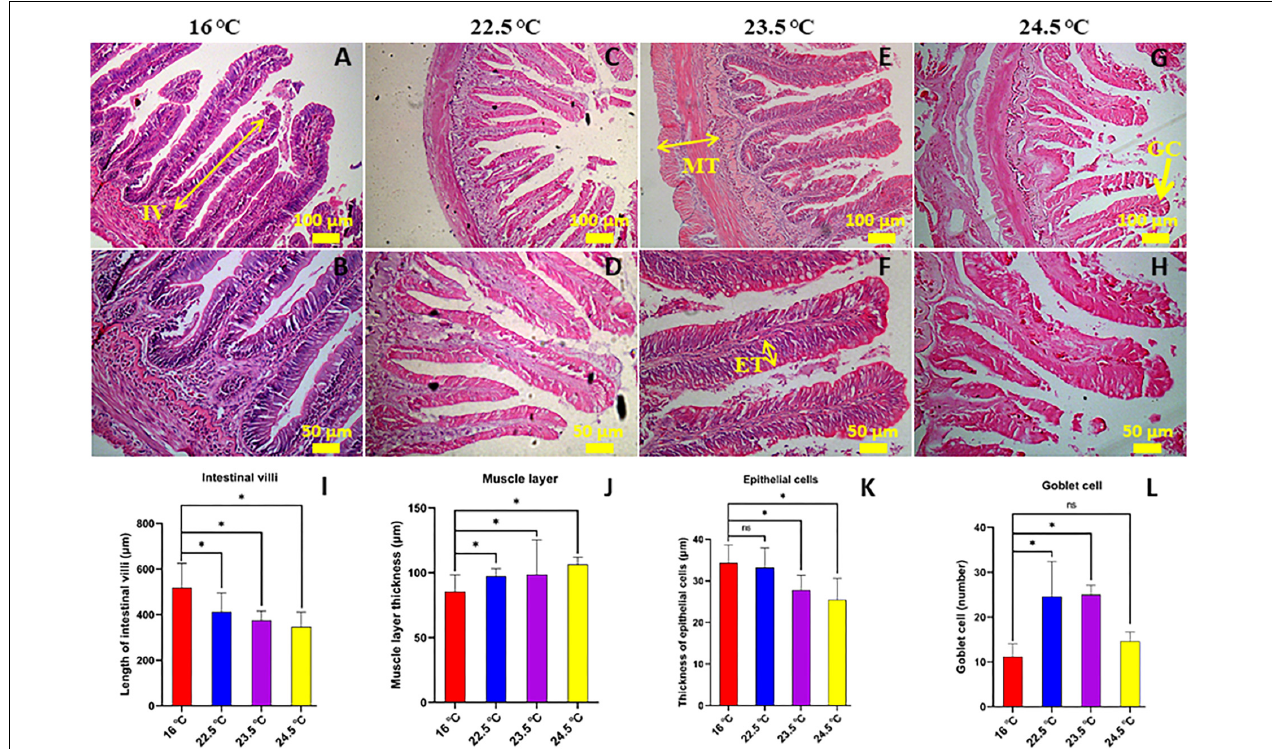
FIGURE 1 | Effects of acute heat stress on the intestinal morphology [the mid-gut stained with H-E]. (A,B) 16 ◦ C control group; (C,D) 22.5 ◦ C-stress group; (E,F) 23.5 ◦ C-stress group; (G,H) 24.5 ◦ C-stress group. IV, length of intestinal villi ( N = 15); MT, muscular layer thickness ( N = 10); ET, thickness of epithelium cell ( N = 25); GC, goblet cell number. Scale bars (A,C,E,G) = 100 µ m; (B,D,F,H) = 50 µ m. (I–L) the measured of mid-gut IV, MT, ET, and GC, respectively. ∗ P < 0.05; ns, no significance.